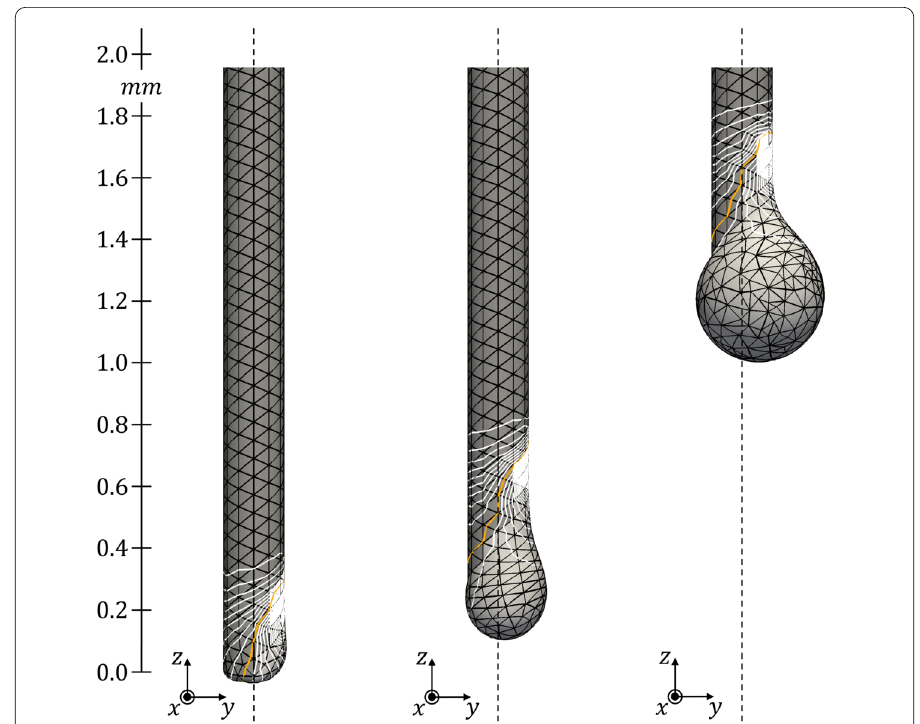
Figure 3 Nucleation and melting phase (Run 12): One-sided nucleated melt at t 10 = 3.68 ms ( left ), transition into a spherical shape at t 25 = 9.20 ms ( middle ) and nearly quasi-stationary melting phase with a spherical melt tilted towards the impinging laser at t 60 = 22.1 ms ( right